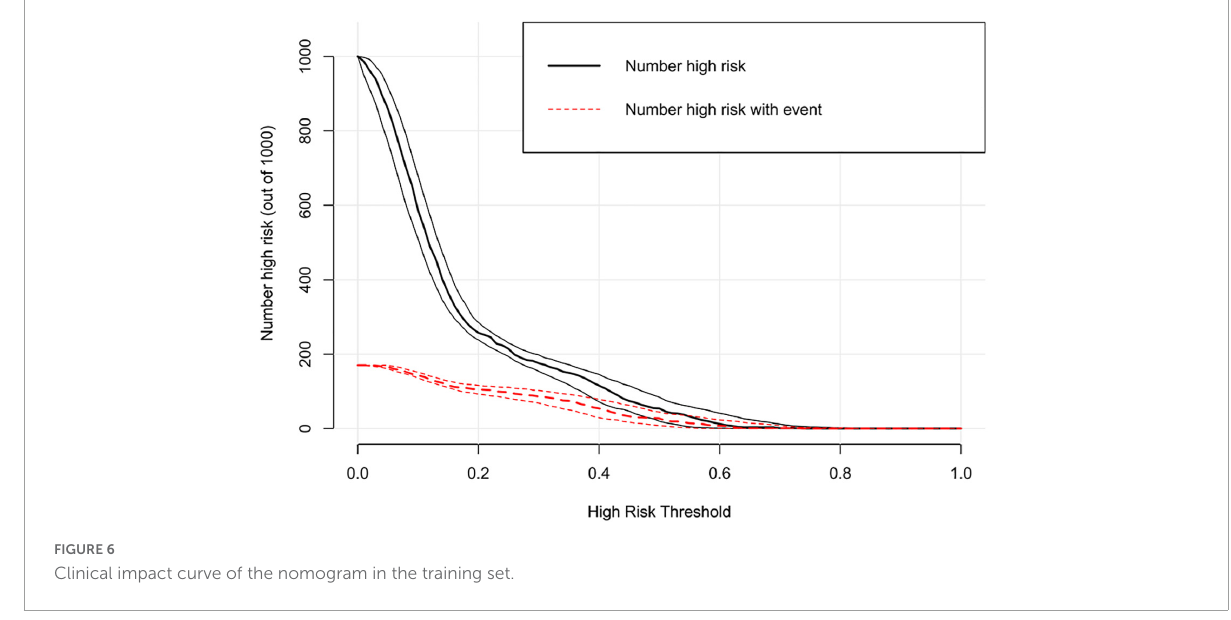
FIGURE6 Clinical impact curve of the nomogram in the training set.